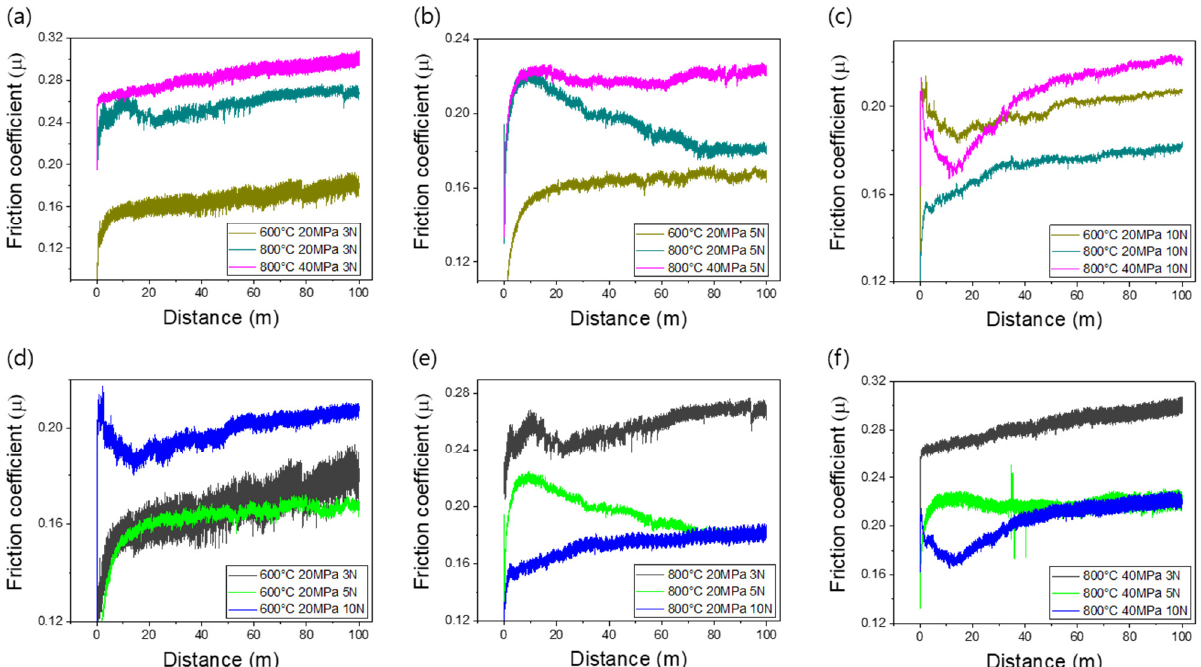
Figure 6. Variations in coefficient of friction (COF) of Cu-based brake pads under different loads: ( a ) 3, ( b ) 5, and ( c ) 10 N. Variations in COF of ( d ) 600-20, ( e ) 800-20, and ( f ) 800-40 samples during ball-on-disc test conducted for 1000 s.